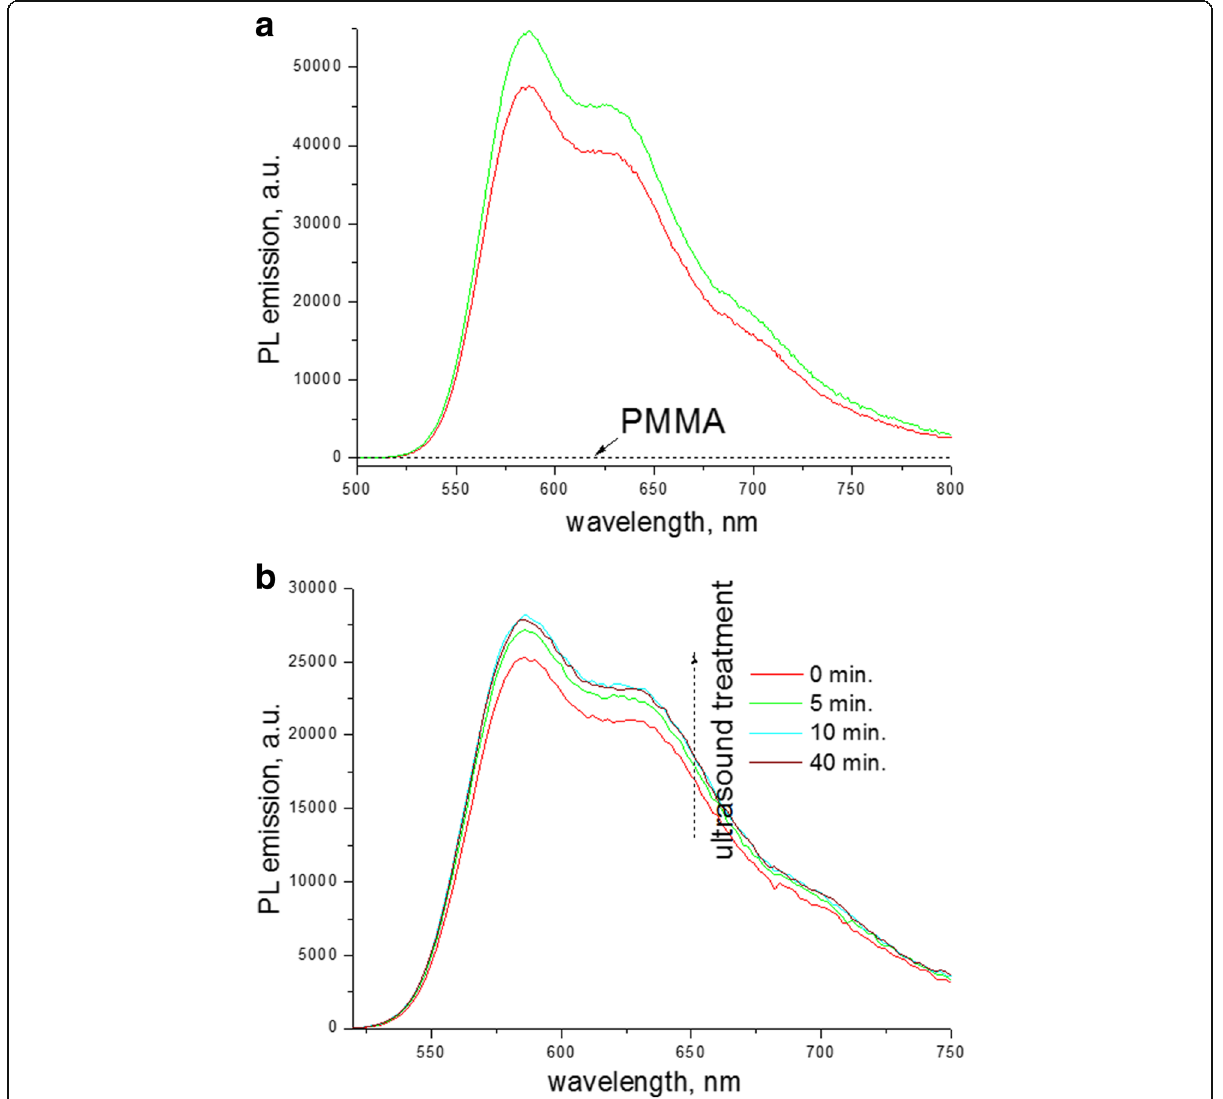
Fig. 9 PL emission spectra ( λ exc = 468 nm) of P3HT solution (0.01 wt%) in CB: a before ( red ) and after ( green ) mixing with solution of PMMA (5.4 wt%), PL spectrum of PMMA is given as well; b upon addition of PMMA powder to the neat P3HT solution ( red ) followed by successive treatment of the cuvette in an ultrasound bath and gradual dissolution of PMMA to ~ 3.25